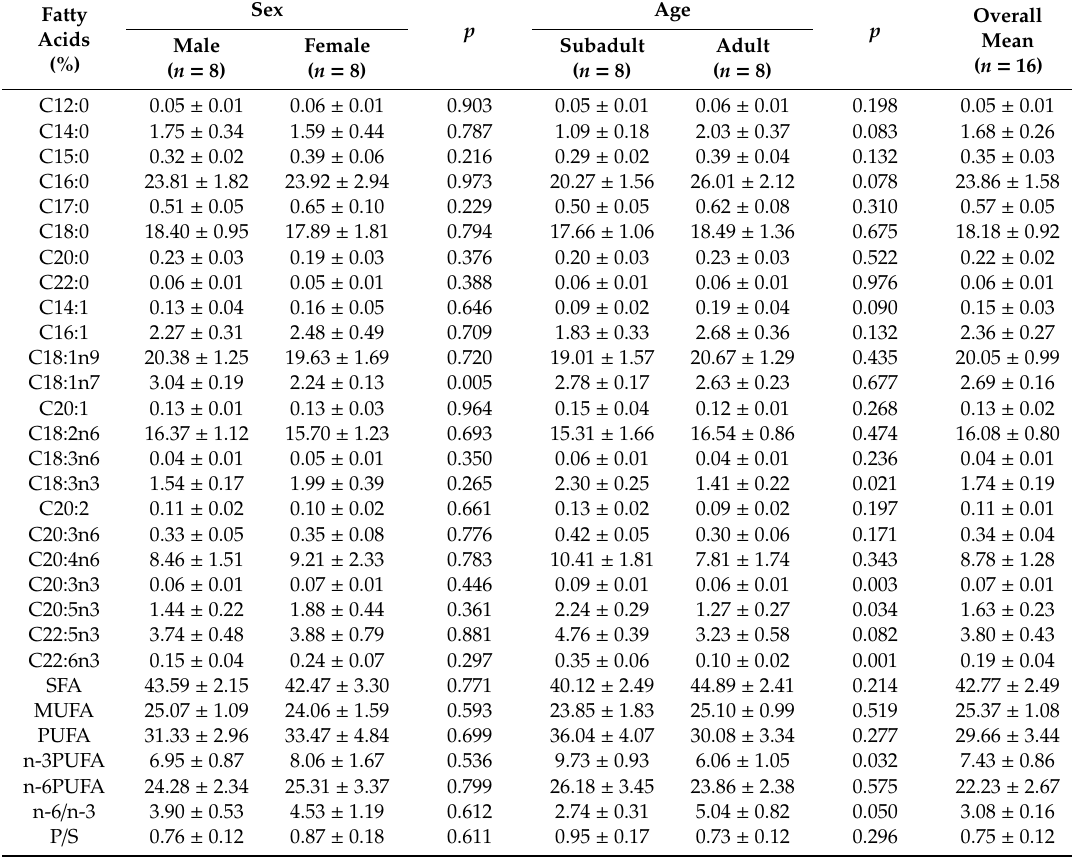
Table 2. Fatty acid composition of axis deer longissimus thoracis , as influenced by sex and age (mean ±